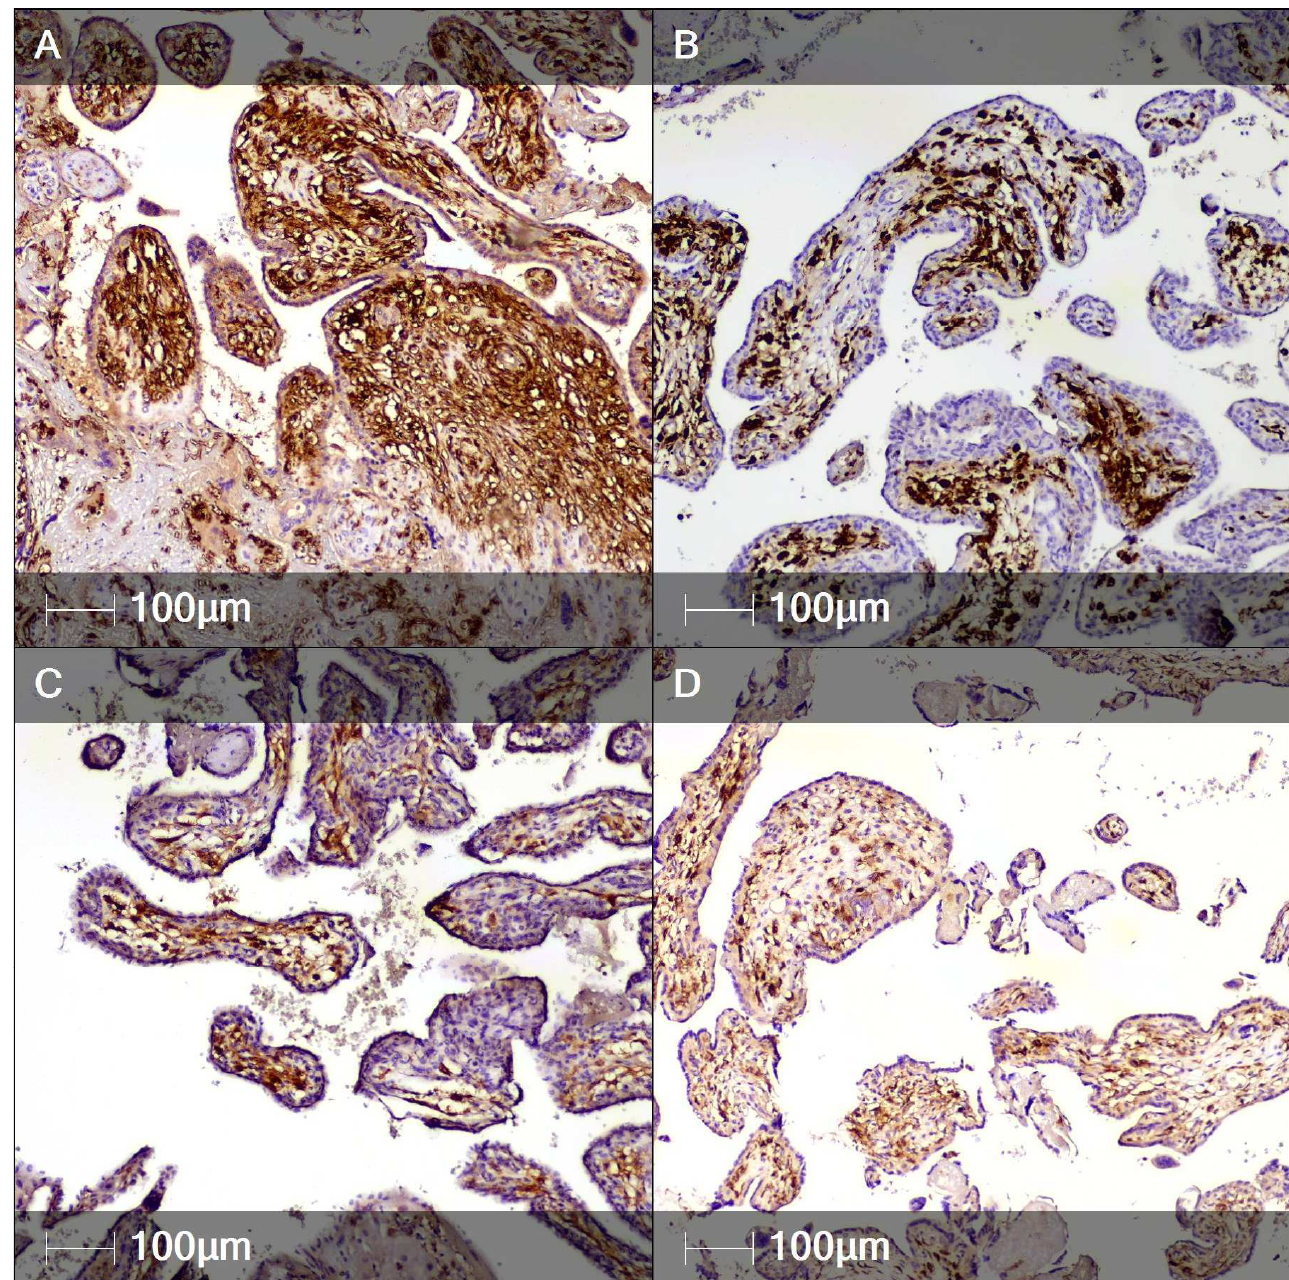
Figure 3. Immunohistochemistry staining of chorionic villi. Representative images of several immune cell markers expressed in the chorionic villi. ( A ) CD14 staining (monocytes); ( B ) CD68 staining (macrophages); ( C ) CD4 staining (T-helper lymphocytes); ( D ) CD8 staining (cytotoxic T-lympho- cytes).